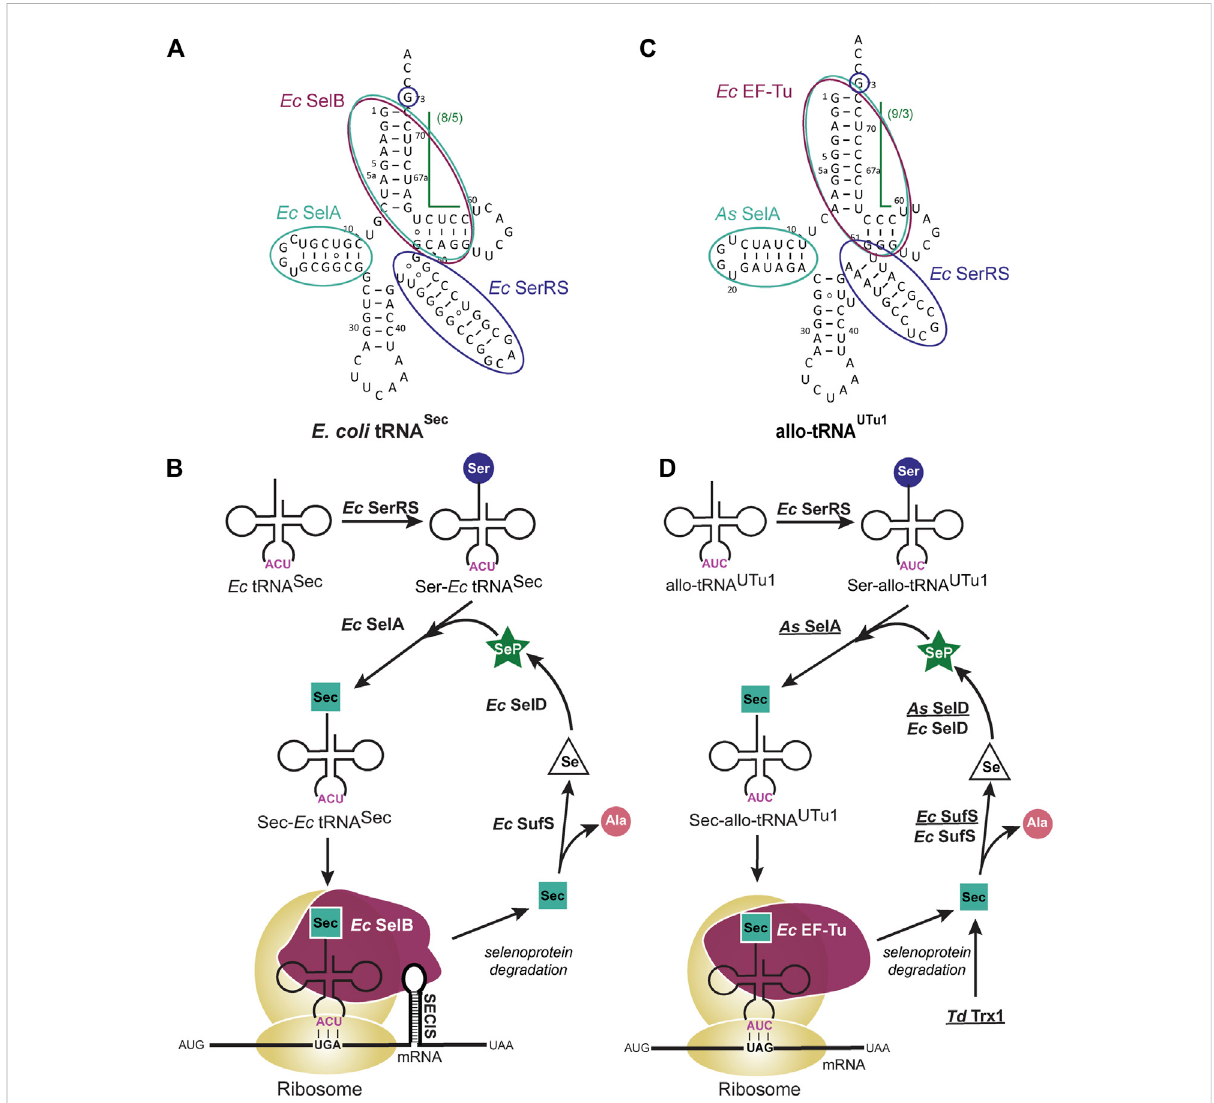
FIGURE 1 Selenocysteine (Sec) tRNA structure facilitates translation and insertion of Sec. (A) Escherichia coli ( Ec ) tRNA Sec secondary structure highlights the features which facilitate its natural biosynthesis and insertion into the growing polypeptide chain. The long variable arm and G73discriminator base(darkblue)arerecognizedby Ec seryl-tRNA synthetase (SerRS)for initial aminoacylationwithSer. Conversionof Ser to Sec occurs through Ec selenocysteine synthase (SelA) which recognizes the D-arm and (8/5) acceptor domain (teal). This 13 bp acceptor domain discriminates tRNA Sec from canonical tRNAs and enables recognition by a specialized elongation factor, Ec SelB (maroon), for insertion into the ribosome. (B) Ec SelB also recognizes an mRNA hairpin [Sec insertion sequence (SECIS) element] that is immediately downstream of the UGA codon for insertion of Sec. Degradation of used selenoproteins releases Sec which is a substrate for Ec Sec lyase (SufS), converting the amino acid to alanine (Ala) and releasing selenium (Se). Se is then converted to selenophosphate (SeP) by selenophosphate synthetase (SelD) where it re-enters the biosynthesis path. (C) allo-tRNA UTu1 secondary structure highlights the features which facilitate a simpler biosynthesis and insertion path for Sec in bacteria. The long variable arm and G73 discriminator base (dark blue) are recognized by Ec SerRS while the D-arm and (9/3) acceptor domain (teal) are recognized by Aeromonas salmonicida ( As ) SelA. Elongation of allo-tRNA UTu1 and insertion of Sec into the polypeptide chain occurs with Ec EF-Tu (maroon) which does not require the restrictive SECIS element. (D) The pSecUAG-Evol plasmid harborsadditional enzymes that are recombinantly expressed (underlined) to promote Sec insertion in this simpli fi ed path. Selenoprotein degradation, including that of the additional Treponema denticola ( Td ) Trx1 releases Sec which is converted to Ala by both recombinant and endogenous SufS. To increase conversion of Se to SeP, both As SelD and Ec SelD are